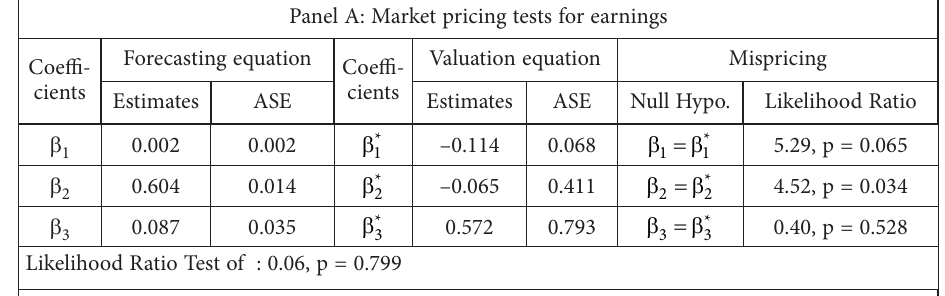
Table 7. Analysis of capital market reactions to sustainable management activities Panel A: Market pricing tests for